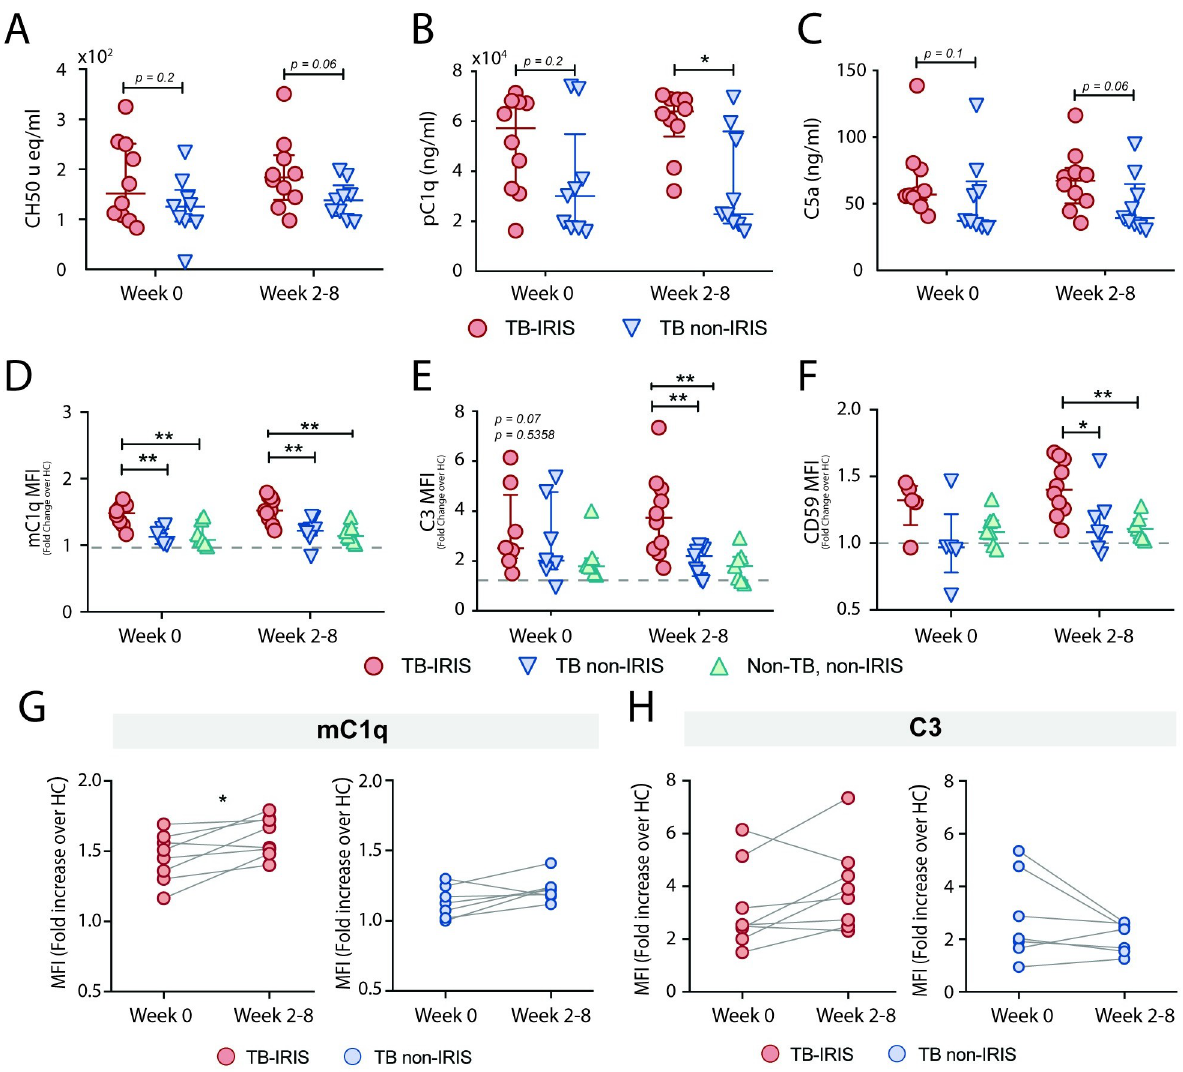
Fig 4. TB-IRIS is accompanied by complement overactivation. ( A ) Serum or ( B )( C ) plasma samples from TB-IRIS and TB non-IRIS patients, before (Week 0) or after ART initiation (Week 2–8), were collected and tested for classical complement activity ( A ), C1q ( B ) or C5a quantification ( C ). Membrane-bound C1q (mC1q) ( D ), C3 ( E ) and CD59 ( F ) expression levels were quantified on total monocytes from TB-IRIS, TB non-IRIS and Non-TB, non-IRIS patients, by flow cytometry. Expression levels (MFIs) were calculated as fold change over their experimental respective HCs. Data are presented as median with interquartile range. � P < 0.05 and �� P < 0.01, when Mann-Whitney test was applied. Longitudinal analysis of pre-ART versus post-ART timepoints for mC1q ( G ) and C3 ( H ) expression levels for TB-IRIS (n = 8, left side) and TB non-IRIS (n = 7, right side) patients. � P < 0.05 was considered statistically significant when Wilcoxon signed-rank test was applied.